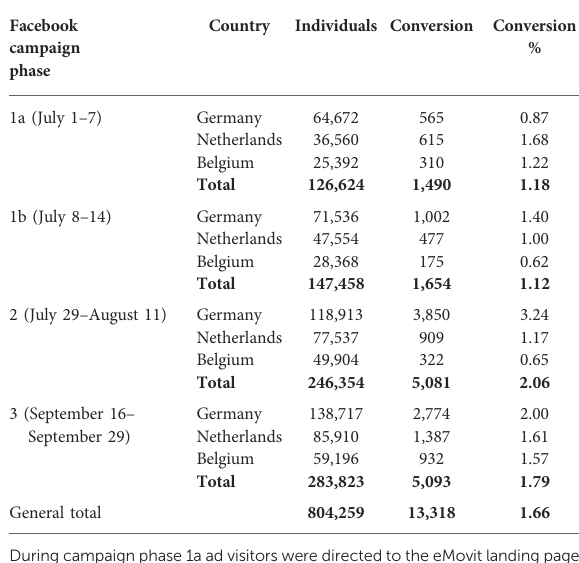
TABLE 2 Emovit paid Facebook advertisements: individuals reached (number of individuals the ad was shown to), number of successful conversions (number of times the ad link was clicked) and percentage of conversions compared to the number of individuals